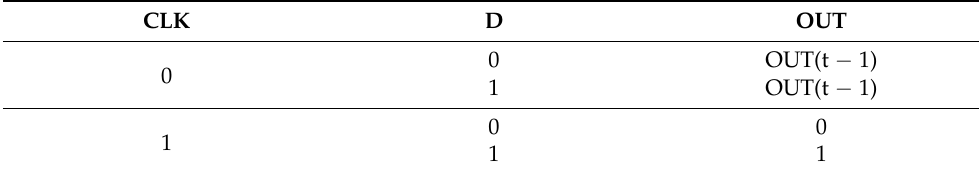
Table 3. Truth table of D-latch.